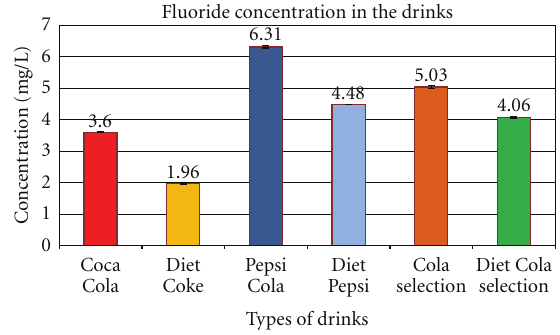
Figure 5: Fluoride concentration in pop colas with samples ( n = 24) directly from the cans. The above graph shows the fluoride concentration (mg/L or ppm) in the six Cola drinks tested. Pepsi has the highest concentration (6.31ppm) while Diet Coke has the lowest concentration